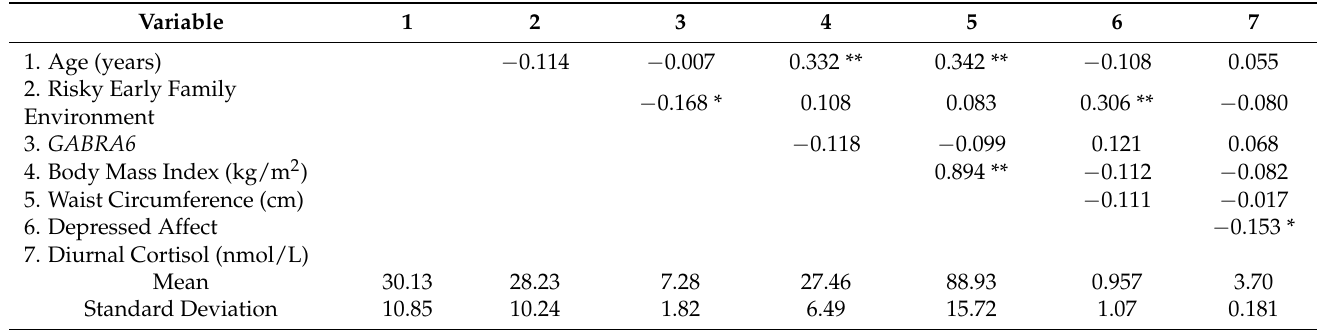
Table 1. Means, standard deviations, and zero-order correlations among study variables.